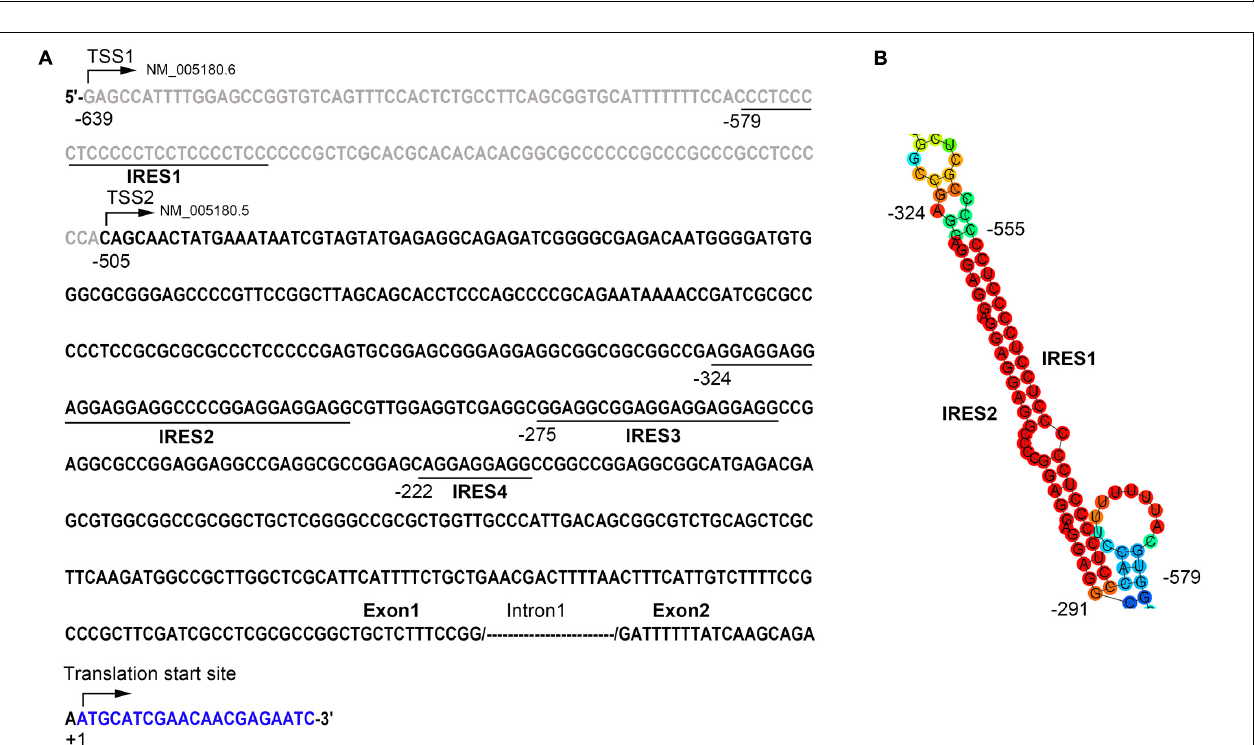
FIGURE 3 | The 5 (cid:48) -UTR region of Bmi1 contains the potential internal ribosome entry sites (IRES) motifs. (A) IRESite database analyses of the region from − 639 to + 1 of Bmi1 5 (cid:48) -UTR sequence; the translation initiation site ATG was assigned as +1. There are four potential IRES elements. (B) The secondary structure of the Bmi1 5 (cid:48) -UTR predicated by RNAfold database showing that the IRES1 and IRES2 motifs form a KMI1 stem loop structure.